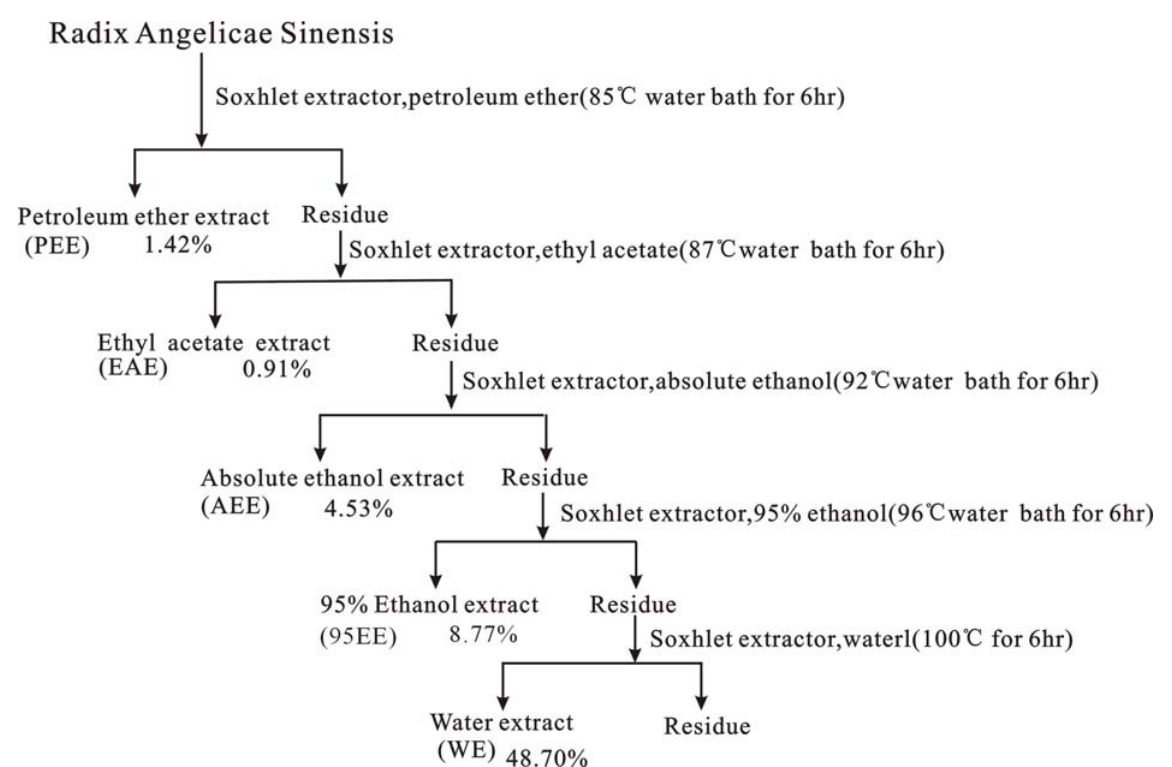
Figure 3. Extraction of Radix Angelicae Sinensis powder by increasing order solvent